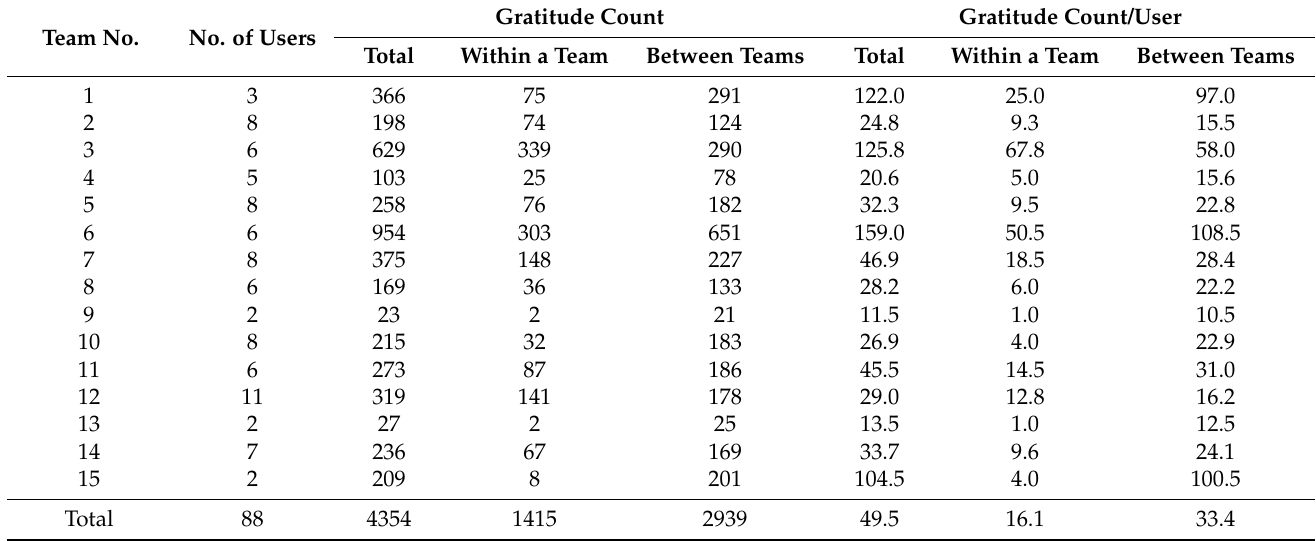
Table 3. Gratitude data count for each team.